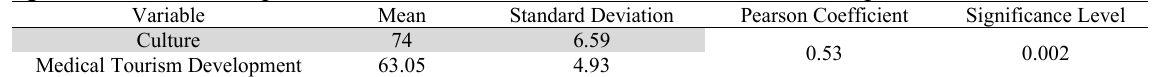
Significant Relationship Test between Culture and Medical Tourism Development